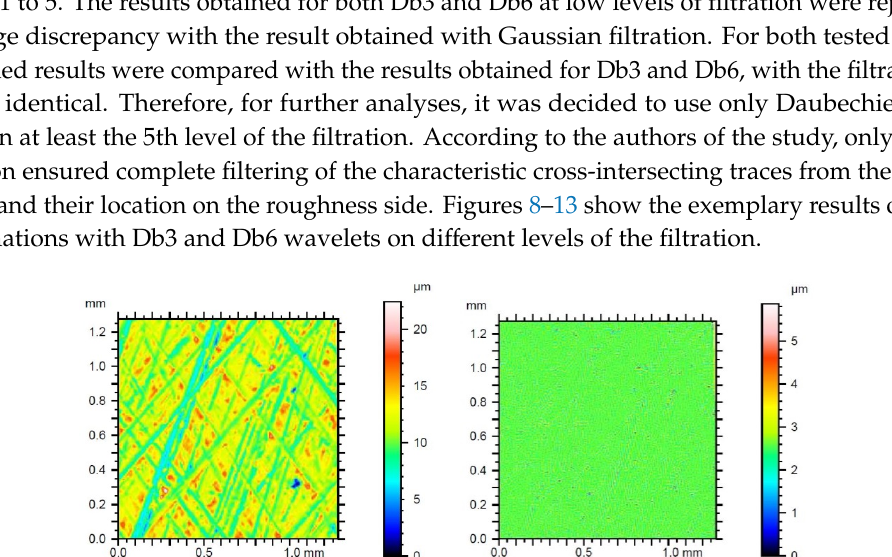
Figure 7. Results of filtration of the surface geometrical structure of sample 1 with Daubechies wavelet on the 1st row with the 6th level of filtration—( a ) waviness, ( b ) roughness.